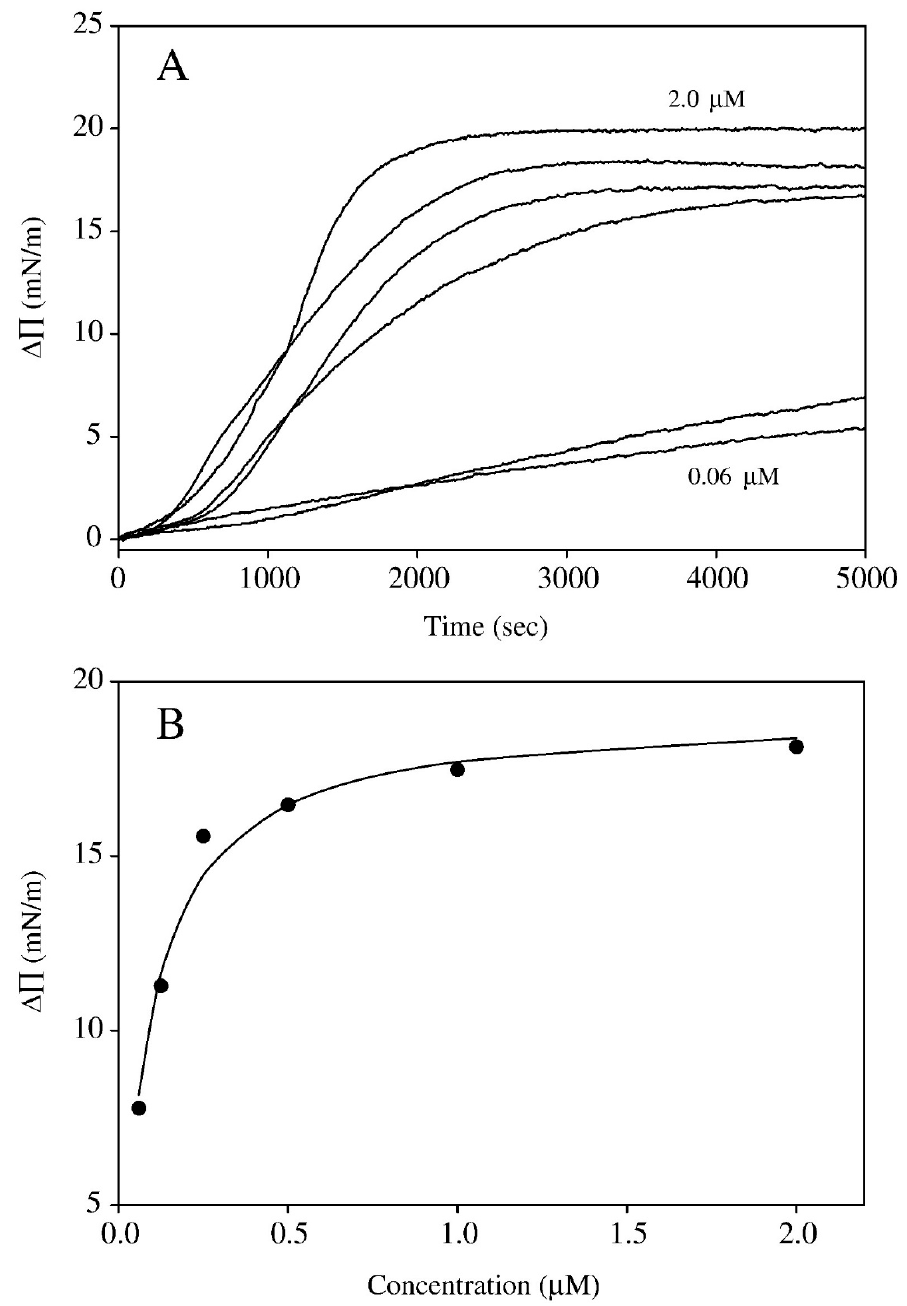
Figure 7. ( A ) The response of mixed monolayers of 7:3 mole ratio DMPC:cholesterol to injection of varying concentrations of tomatine. The monolayers were compressed to 10 mN m − 1 prior to injection. The concentrations studied were 2.0 μ M, 1.0 μ M, 0.5 μ M, 0.25 μ M, 0.125 μ M, and 0.06 μ M. At the later times, these curves fall in order of concentration on the graph from lowest to highest. The subphase is 0.05 M pH 7.0 phosphate buffer, 0.10 M NaCl. ( B ) Binding curve of the measured plateau values of Δ Π at long time plotted versus subphase concentration of tomatine. The Δ Π values for the two lowest tomatine concentrations are determined at much longer times near 12,000–14,000 s. The Δ Π values are an average for two complete data sets. Reproduced with permission from reference [82].